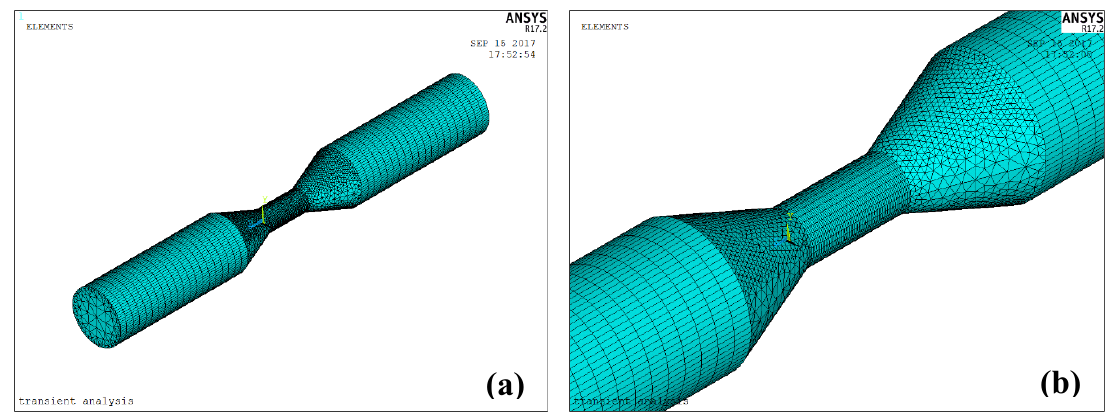
Figure 4. Finite element mesh used in thermo-mechanical analysis: ( a ) general view; ( b ) local magnification.